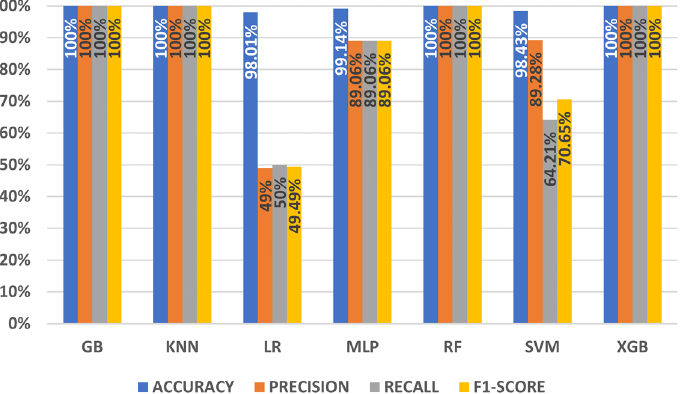
Figure 4. Histograms of the performance of our seven ML-based classifiers on our REAL-880 training set.